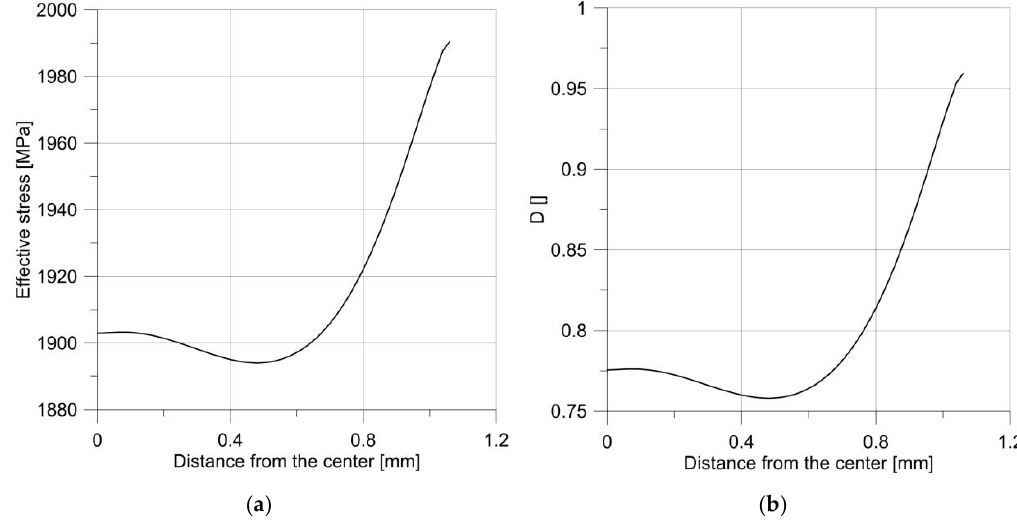
Figure 11. Distribution of effective stress ( a ) and parameter D ( b ) just before the moment of failure of the specimen with the notch R = 1 mm.